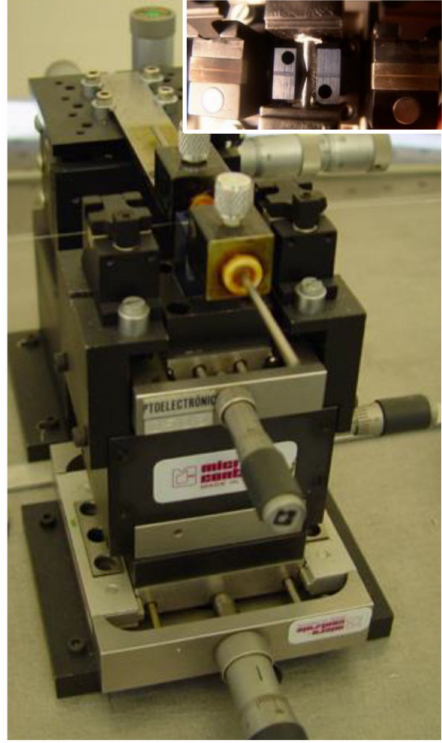
Figure 3. Central block showing the electrodes’ support insulated with Teflon and the v-grooves mounted in different positioners. Inset: closer view of the electrodes and the v-grooves for fiber